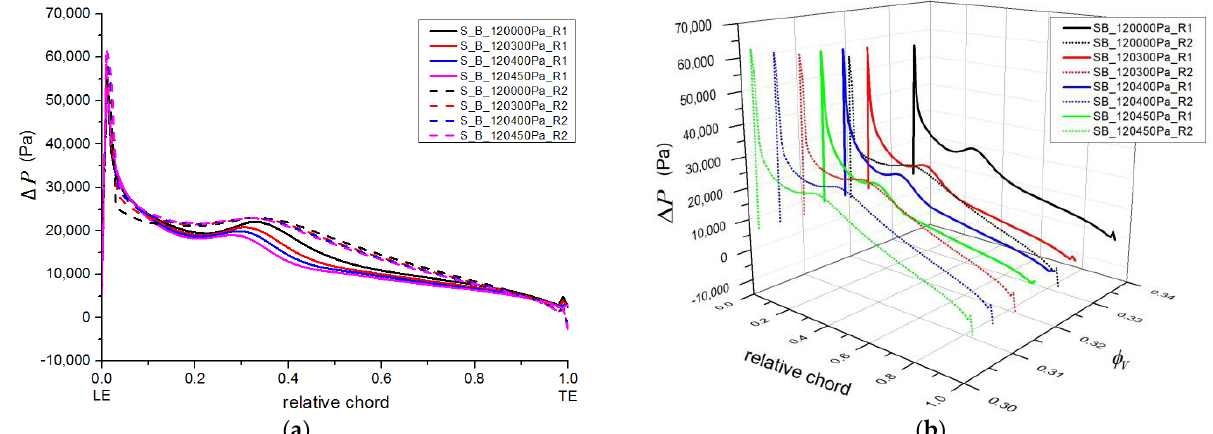
( b ) Figure 12. Relative leakage flow distribution with the S_B model at 6000 rpm. ( a ) First-stage rotor, R1, and ( b ) second-stage rotor, R2.